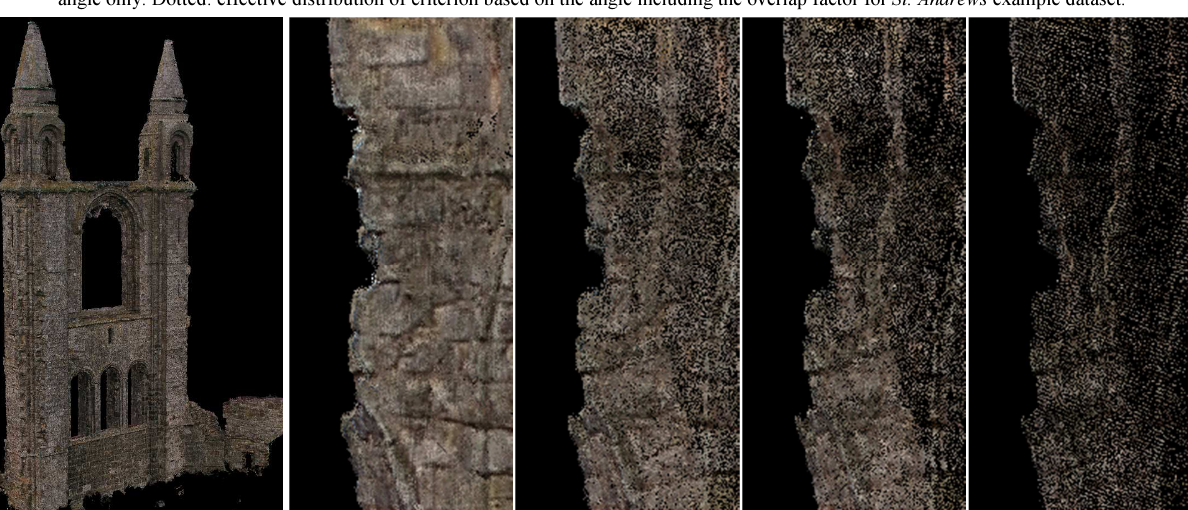
Fig. 2.4: Resulting point cloud after stereo models selection and dense image matching with SURE. Left: full view, filtered with maximum occurence 1. Right: Detail from full cloud (49.1 Mio. pts.), filtered with mo 1 (7.1 Mio. pts.), filtered with mo 2 (3.8 Mio. pts.), filtered with mo 4 (1.9 Mio.